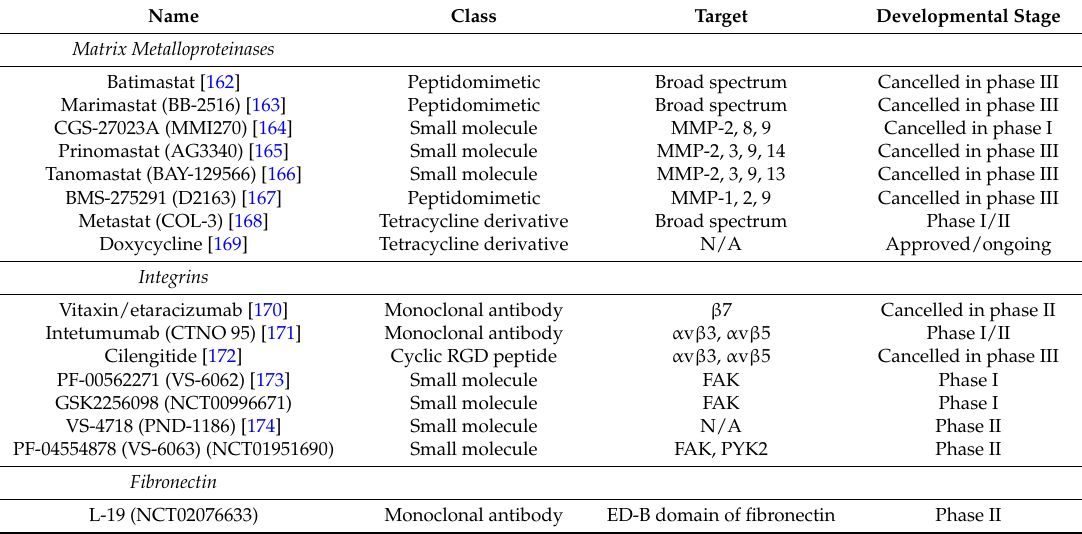
Table 1. Clinical development of agents targeting TGF- β